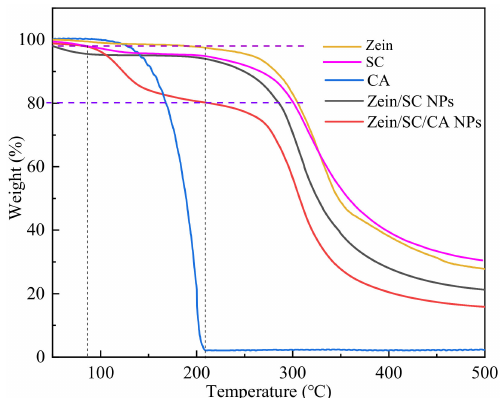
Figure 11. TGA curves of zein, SC, CA, zein/SC NPs, and zein/SC/CA